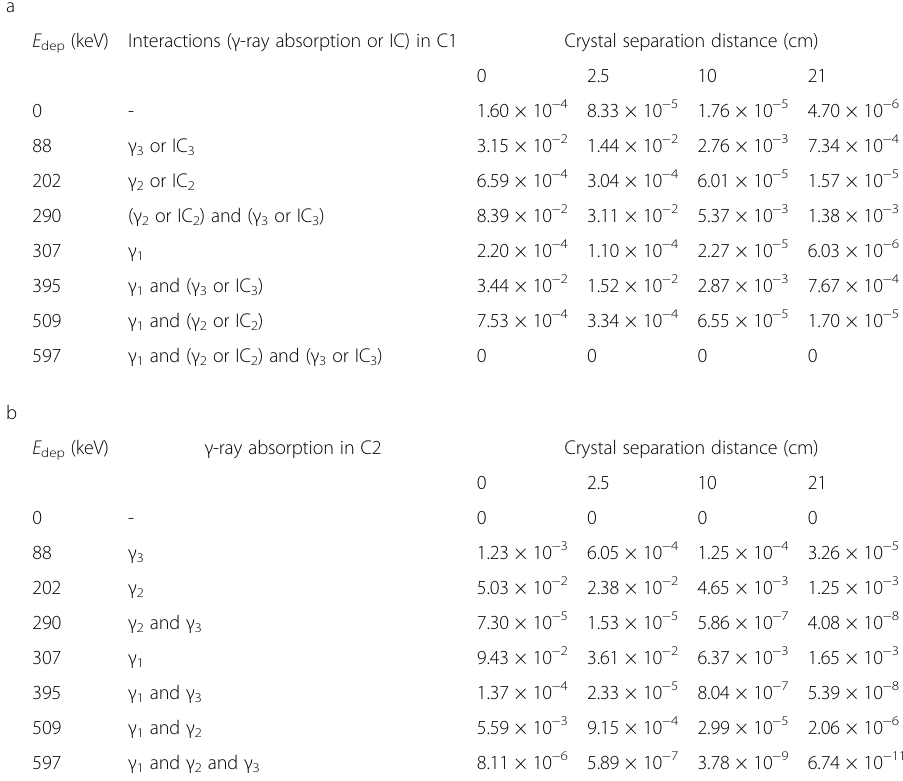
Table 2 Coincidence detection probabilities for each value of deposited energy obtained from the analytical model due to (a) β − decay followed by its subsequent 176 Hf isomeric transition particles interacting in the source crystal (C1) and (b) γ -ray absorption in the detector crystal (C2) a E γ -ray absorption or IC) in C1 Crystal separation distance dep (keV) Interactions (